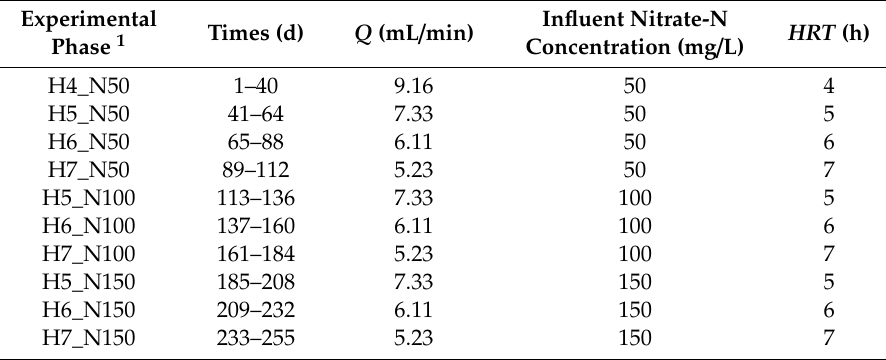
Table 1. Operational parameters for the respective experimental